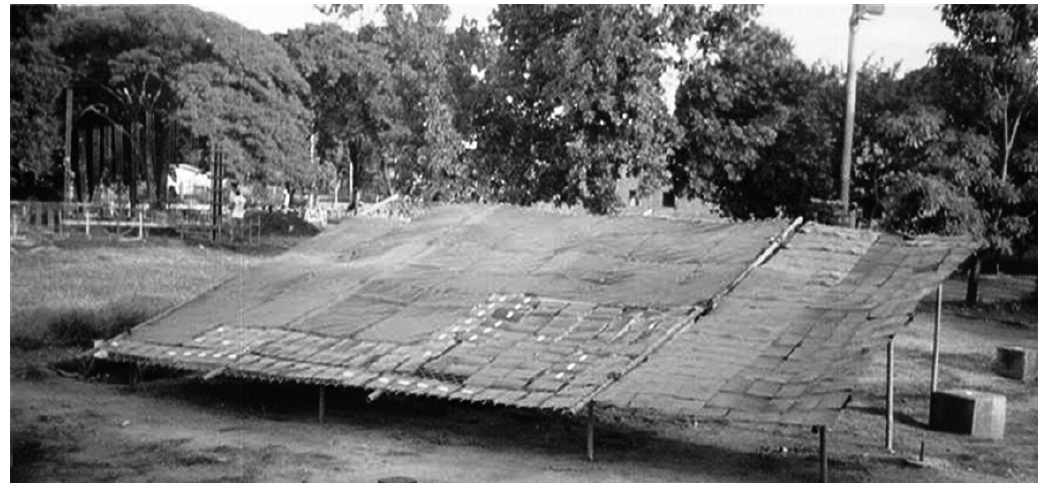
Figure 1. HDPE and PVC geomembranes samples exposed to